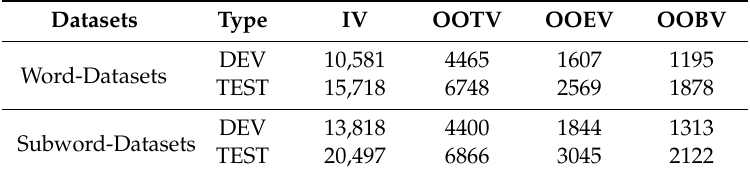
Table 5. Statistics of the division on each corpus.